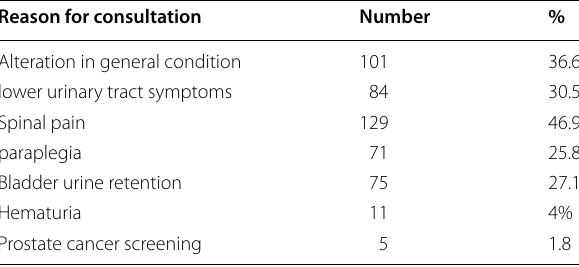
Table 1 Distribution of patients by reason for consultation